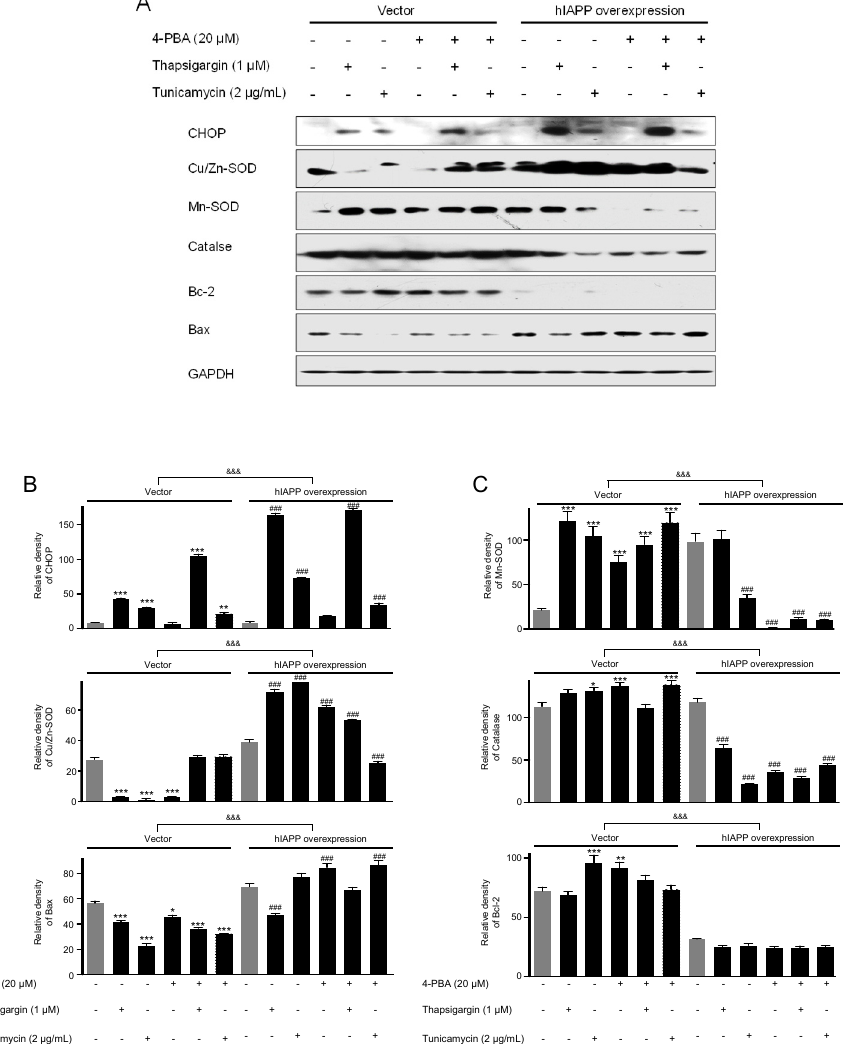
Figure 3. The expressions of CHOP, Cu/Zn-SOD, Mn-SOD, catalase, Bcl-2, and Bax proteins in pCMV-Entry-expressing cells and INS1E-hIAPP-overexpressing INS-1E cells under ER stress conditions. INS-1E cells were incubated in RPMI 1640 medium supplemented with 2% fetal bovine serum with/without thapsigargin (1 μ M) for 6 h or tunicamycin (2 μ g/mL) for 16 h and/or with/without 4-PBA (20 μ M) at 37 °C with 5% CO 2 . CHOP, Cu/Zn-SOD, Mn-SOD, catalase, Bcl-2, and Bax were then analyzed by Western blot ( A ). The relative amounts of CHOP, Cu/Zn-SOD, and Bax ( B ) and Mn-SOD, catalase, and Bcl-2 ( C ) were quantified as described in Materials and Methods. Data represent the mean ± SEM of three experiments. * p < 0.05, ** p < 0.01, *** p < 0.001 vs. 2% FBS in pCMV-Entry-expressing cells; ### p < 0.001 vs. 2% FBS in INS1E-hIAPP-overexpressing cells; &&& p < 0.001, pCMV-Entry-expressing cells vs. INS1E-hIAPP-overexpressing cells.